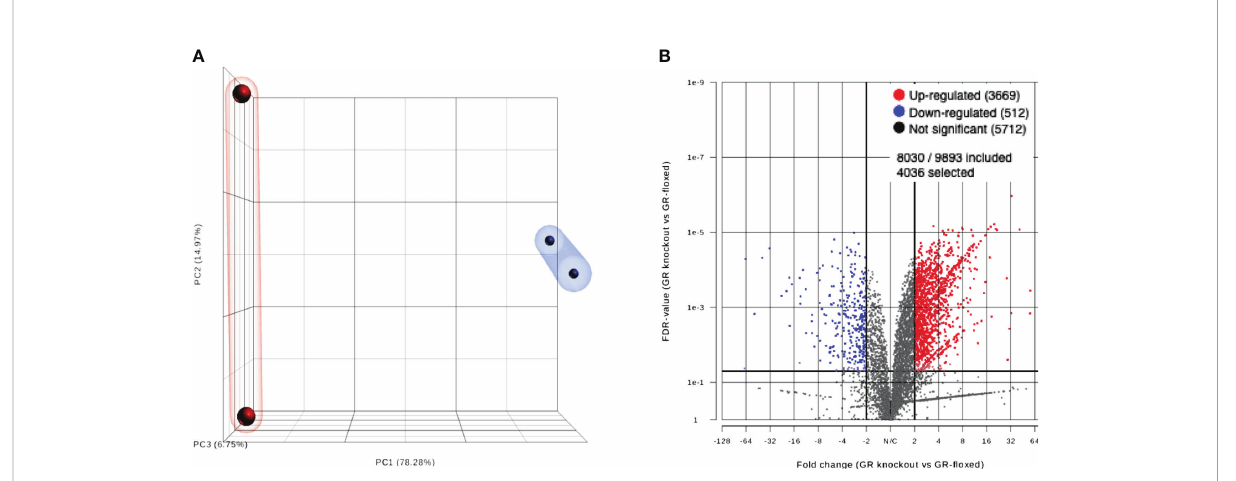
FIGURE 1 (A) PCA plot showing a clear separation between GR cKO and WT samples. (B) Volcano plot showing the number of upregulated (red dots) and downregulated (blue dots) genes. Gray dots denote no signi fi cant